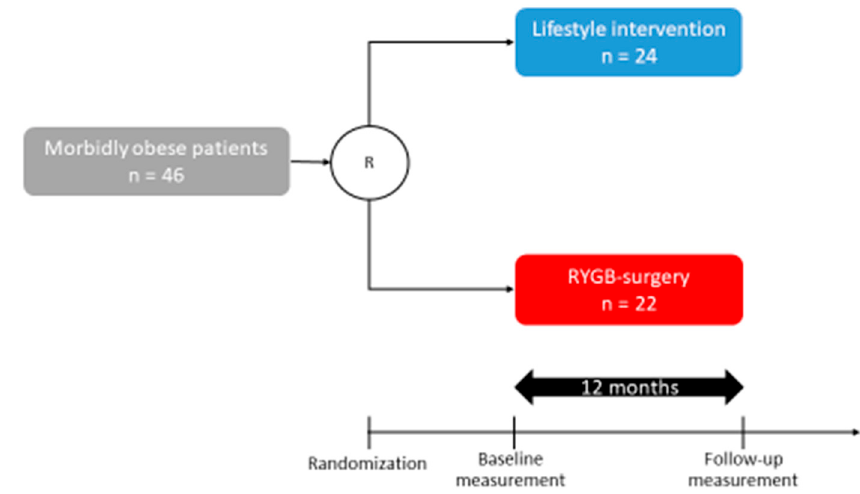
Figure 7. Time schedule of the WAS trial. R,